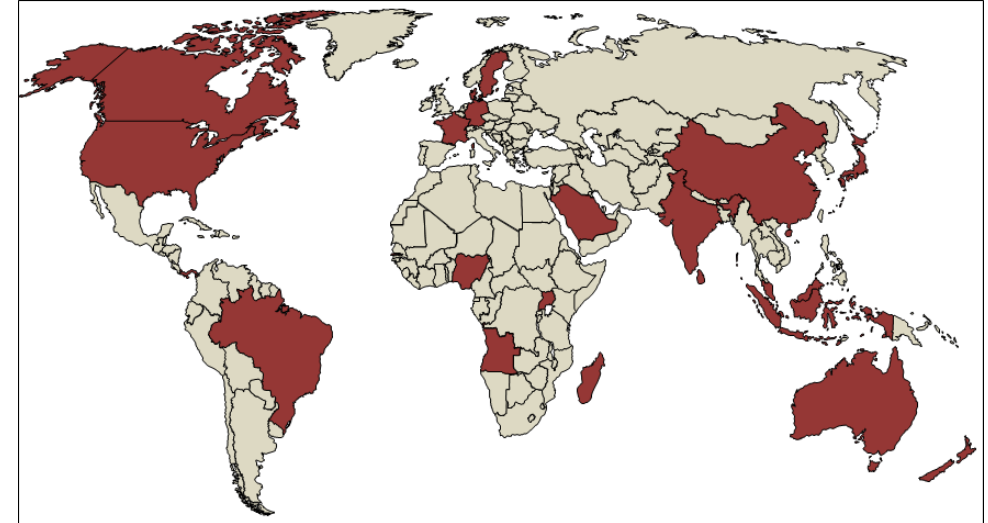
Figure 6. Map depicting locations (countries in red) where reports of water mite predatory and parasitic associations were obtained for this review.